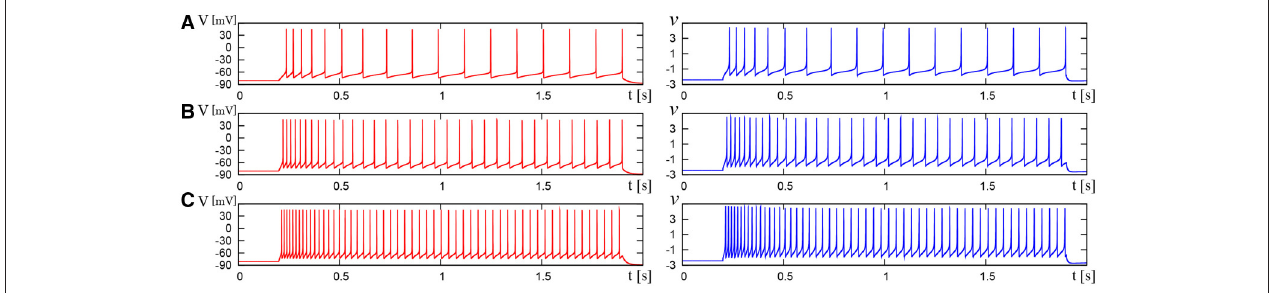
FIGURE 8 | Waveforms of Pospischil and DSSN models, corresponding to an inhibitory neuron in the RS class. The Pospischils’ model (left) generates periodic spikes in response to a step input rising at t = 0.2 where I stim is (A) 0.6, (B) 1.1, (C) 1.7 nA. The DSSN model (right) generates periodic spikes in response to